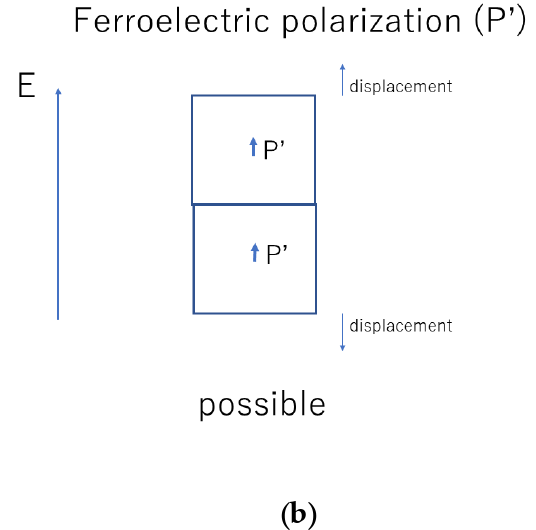
Figure 10. Flexo- ( a ) and ferro-electric ( b ) polarization under applied alternating electric field (E) for tightly joined BaTiO 3 nanocubes in an ordered assembly. Reprinted with permission from Ref. [167]. Copyright 2020, MDPI.